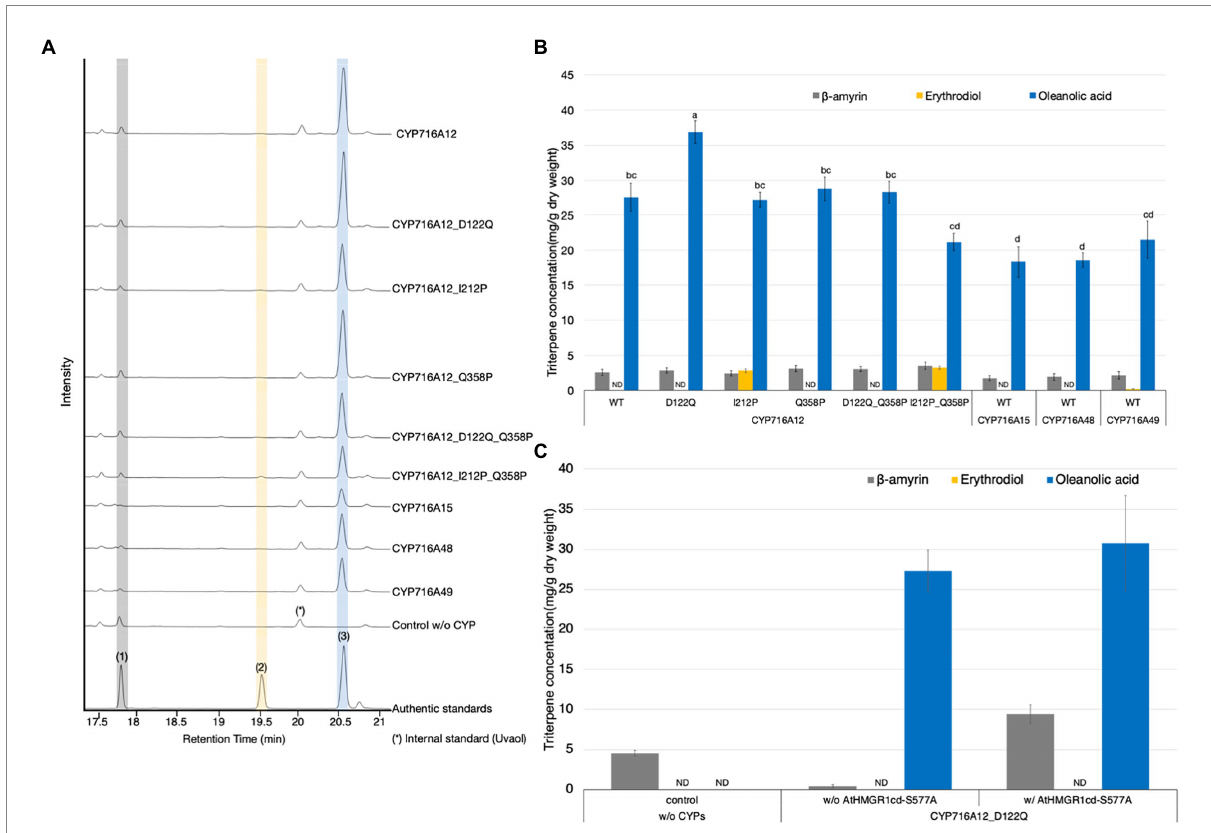
FIGURE 4 Identification of CYP716A with the highest potential for high-level oleanolic acid production in Nicotiana benthamiana using the Tsukuba system. (A) TICs of extracts from N . benthamiana leaves transiently expressing a combination of LjOSC, LjCPR2, and mutant CYP716A12s (D122Q, I212P, Q358P, D122Q Q358P, and I212P Q358P), wild-type CYP716As (CYP716A12, CYP716A15, CYP716A48, and CYP716A49), or empty vector as a control. β -Amyrin ( 1 ), erythrodiol ( 2 ), and oleanolic acid ( 3 ) were used as authentic standards. Uvaol (*) was used as an internal standard. (B) Quantification of triterpene concentration in N . benthamiana leaf extracts analyzed in (A) . (C) The accumulation of triterpenes in N . benthamiana leaves transiently expressing a combination of LjOSC1, LjCPR2, and CYP716A12_D122Q with or without AtHMGR1cd-S577A. Values and error bars represent the mean and standard deviation, and the data are representative of at least three biological replicates with similar results from three independent experiments ( n = 9). Letters indicate significant differences in the levels of oleanolic acid (a–d) among samples (one-way ANOVA with Tukey’s post-hoc test, p < 0.05). ND, not